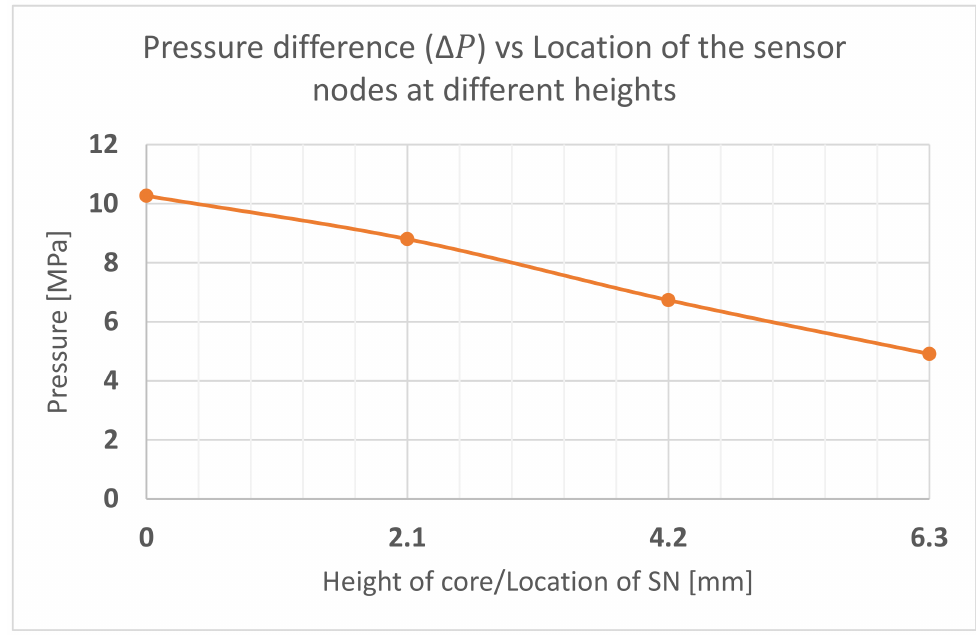
Figure 13. Pressure difference vs. the height of the core pin. The sensor nodes at the front and back were used to simulate the pressure difference. See Figure 9 for sensor node